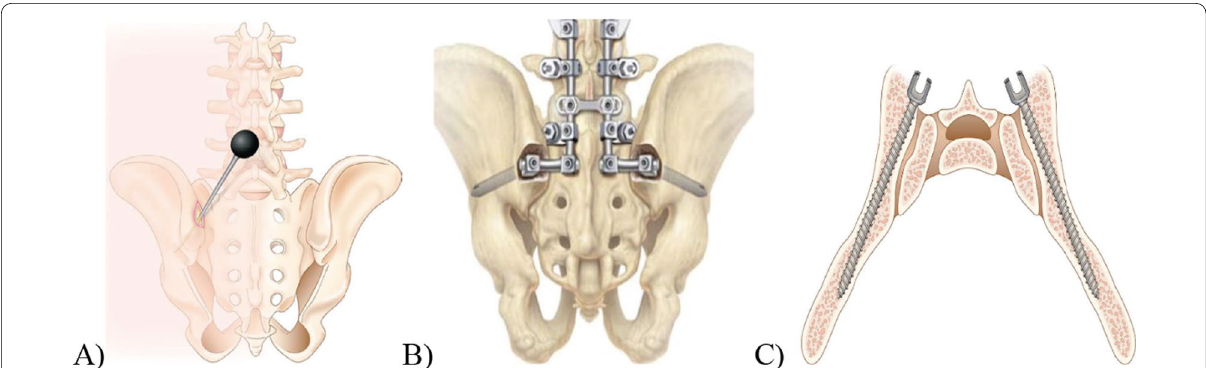
Fig. 13 Open iliac screw insertion technique A Entry point preparation and trajectory. B conventional iliac screws are connected to the rods via modular connectors. C A modified technique minimizes screw prominence by medializing the screw head obviating the need for modular